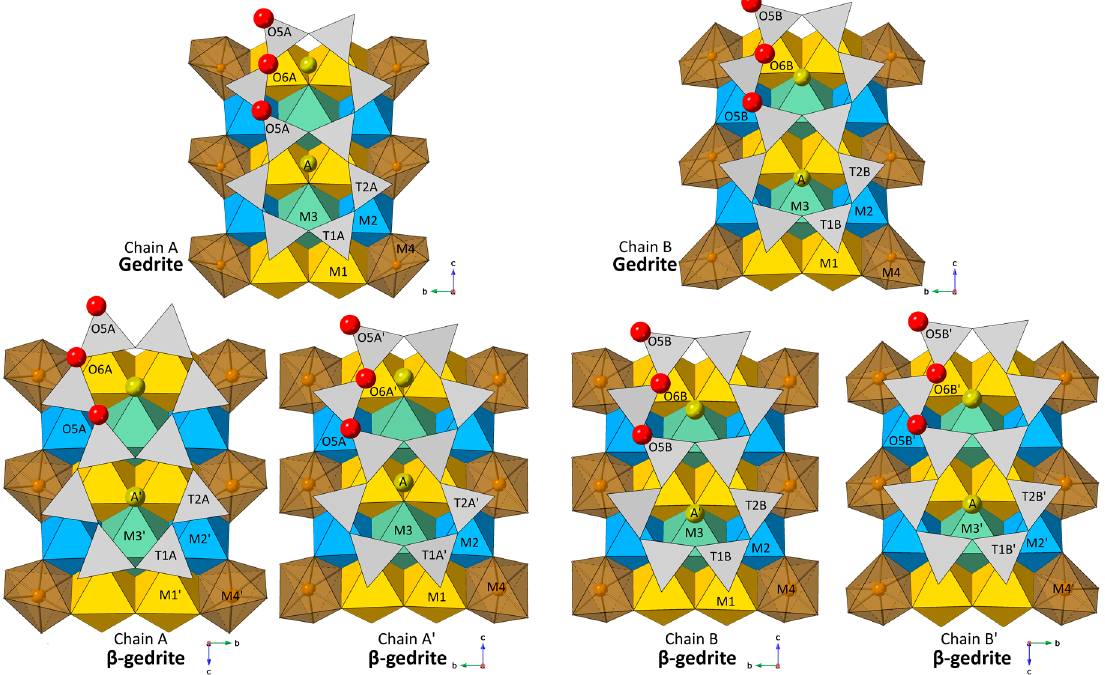
Figure 1. (100) projection of the partial structure of gedrite showing the structural changes from gedrite ( Pnma ) to β -gedrite ( P 2 1 / m ). The reduction in symmetry splits the double-chains of tetrahedra into four nonequivalent chains in the P 2 1 / m phase. The A chain in the β -gedrite structure has S-type rotation while the A’,B and B’ chains are O-rotated. Oxygen atoms are shown as red spheres. O5–O6–O5 angles are measured as the obtuse angle.